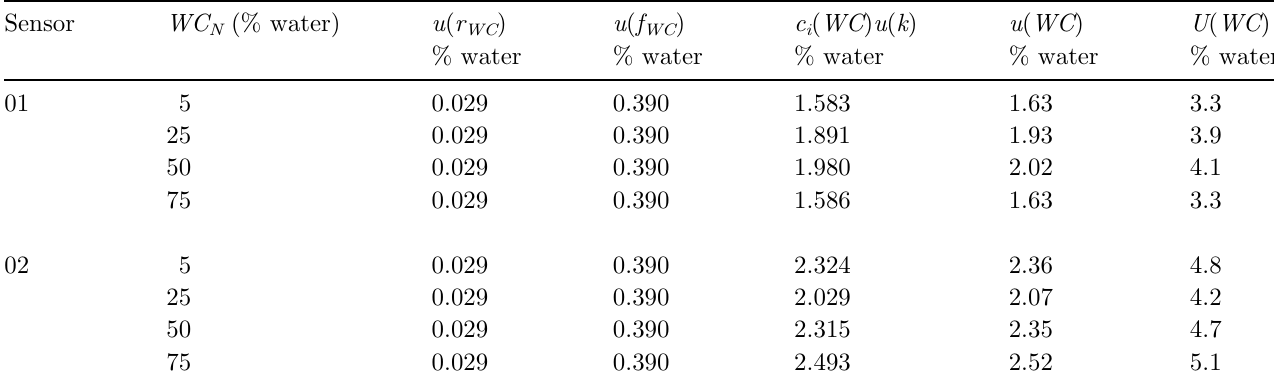
Table 8. Uncertainties for the water content of the binary mixtures.